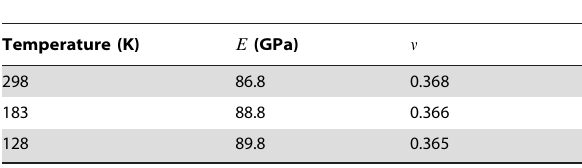
Table 1. Elastic